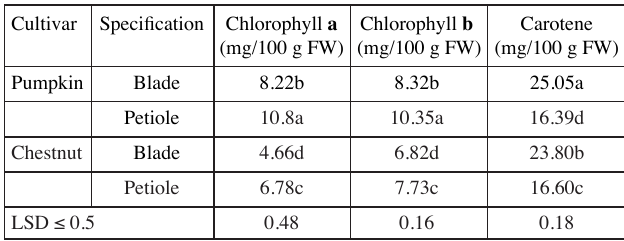
Tab. 1: Chlorophyll and total carotene content in sweet potato blade and petiole. Cultivar Specification Chlorophyll a Chlorophyll b